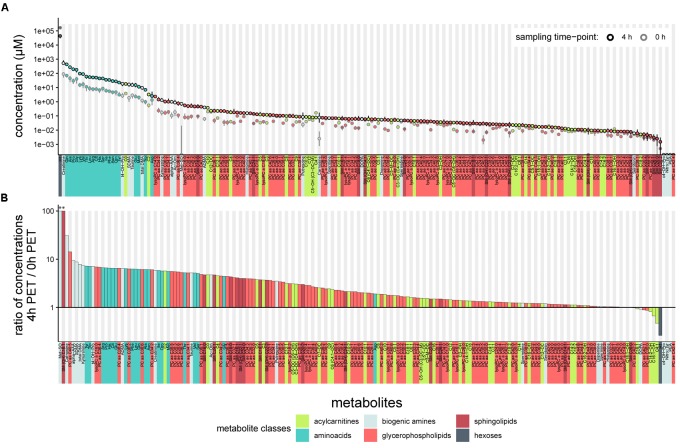
Concentrations of 188 targeted metabolites in PD effluents after a standardized 4-h peritoneal equilibration test (PET). (A) Median metabolite concentrations (circles) in PD effluents (standard PD fluid with 3.86% glucose). Bars above and below circles indicate upper and lower quantiles; semicircles represent undetected metabolites. Of 188 metabolites, 184 were detected after a 4 h PET dwell (black-outlined circles) and 182 in samples at the 0 h PET time point (immediately taken after initial filling of the PD fluid; gray-outlined circles). (B) Ratios of PD effluent metabolite concentrations after 4 h as compared to the 0 h sampling time. Ratios > 1 indicate higher levels after 4-h dwell, ratios < 1 indicate decreased concentrations after 4-h dwell as compared to 0 h, or complete absence of the metabolite at both sampling time-points (c4-OH-Pro, Nitro-Tyr, PEA, PC ae C42:4). Methionine Sulfoxide (Met-SO) and sphingomyelin SM (OH) C16:1 (see astericks “∗∗” above leftmost columns) were undetectable at initial sampling (0 h) and were assigned ratio values of 100. aa, in glycerophospholipids (GLP) both moieties bound by ester bonds to the glycerol backbone, ae, in GLP moieties bound by one ester and one ether bond to the glycerol backbone.